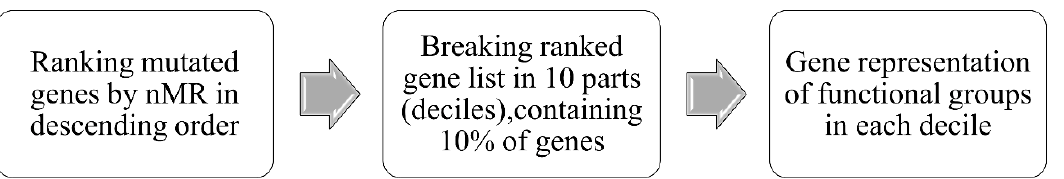
Figure 1. Pipeline for bioinformatic analysis of gene mutation frequencies corresponding to functional groups of molecular pathways.